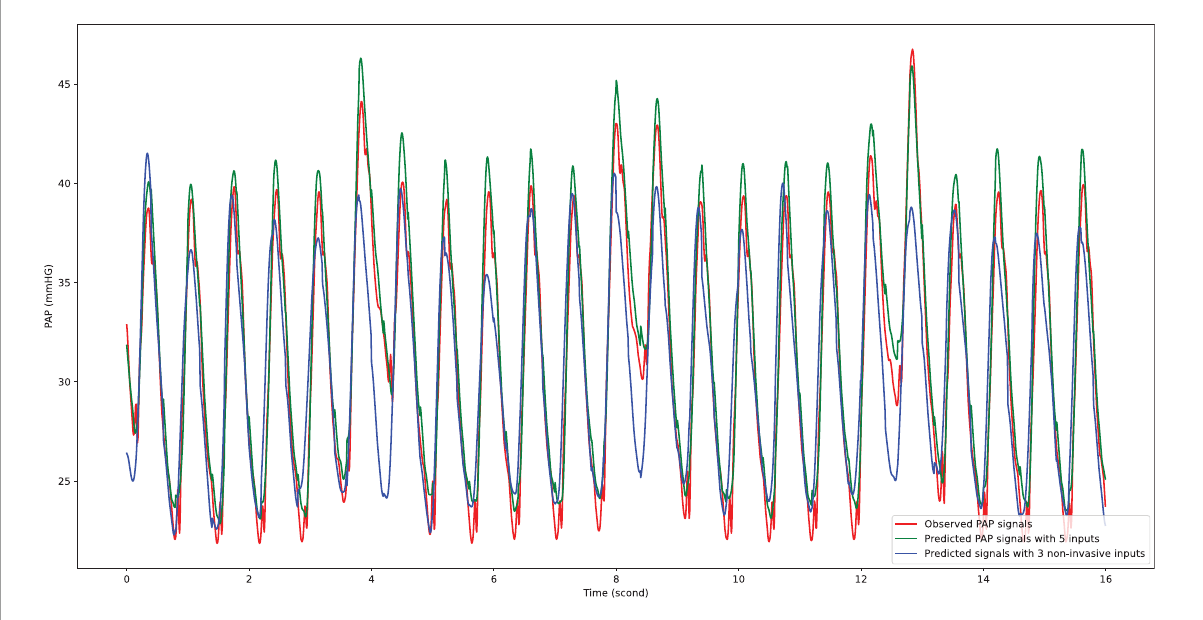
FIGURE5 Prediction result compared with observational data. To inspect the prediction result visually, a randomly selected segment of observational PAP signal was compared with prediction ones given by AI model with five input signals and three ones, respectively. The red line presents the